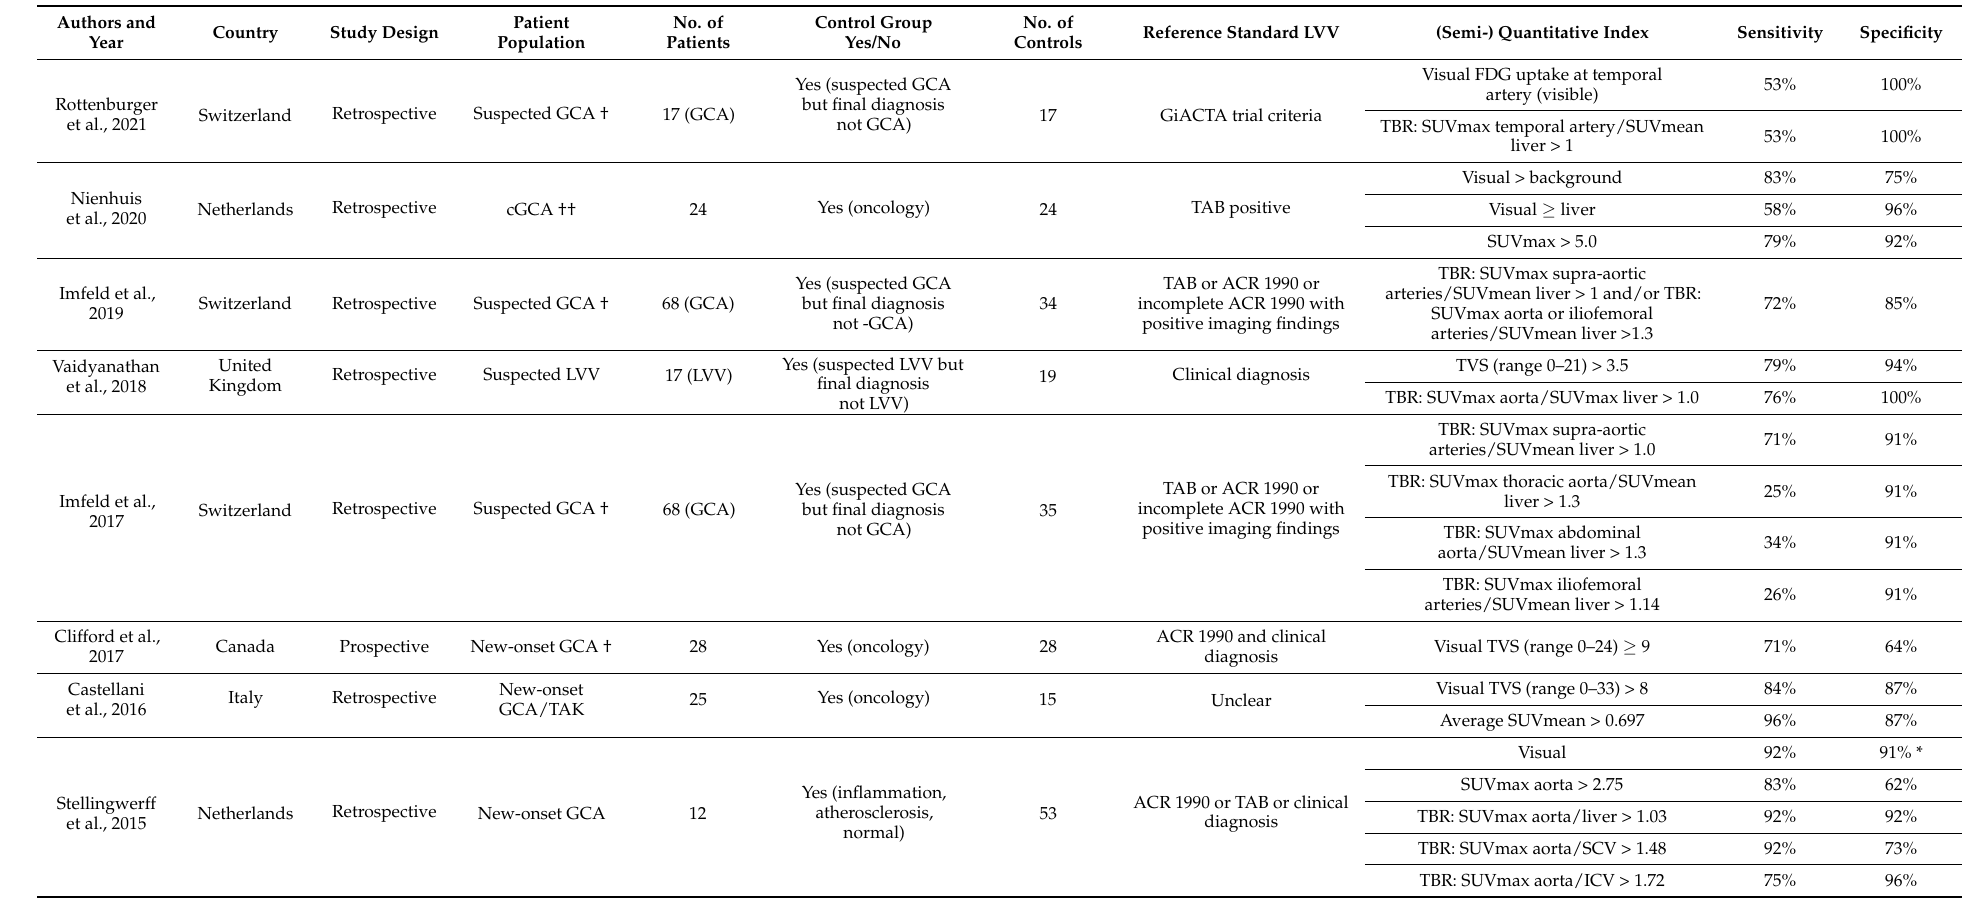
Table 1. Overview of studies reporting diagnostic accuracy of semi-quantitative indices for GCA or TAK . Only studies in which all patients underwent [ 18 F]FDG-PET/CT were selected. † At least part of patients receiving treatment at the time of the scan. †† At least part of the patients received treatment for less than 3 days before the scan. FUO = fever of unknown origin. GCA = giant cell arteritis. ICV = inferior caval vein. IJV = internal jugular vein. SCV = superior caval vein. TAB = temporal artery biopsy. TAK = Takayasu’s arteritis. TVS = total vascular